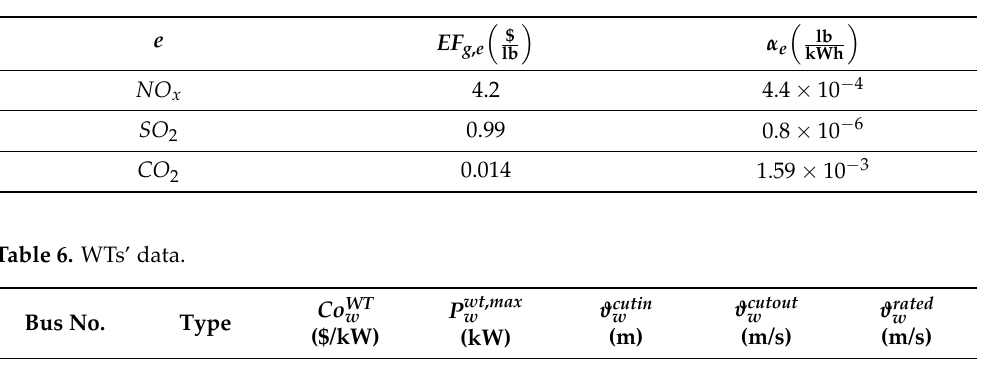
Table 5. Emission data.